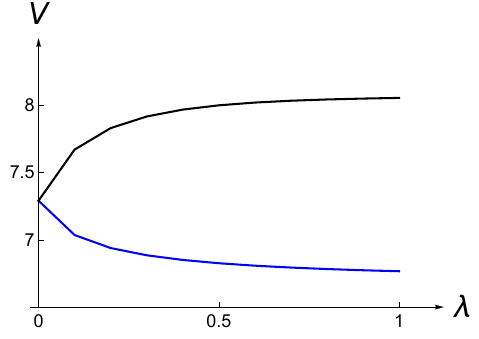
Figure 2. The value function V w.r.t. λ . The parameter set is r = δ = 0.03, σ = 0.3, X 0 = 10, K 1 = 10, K 2 = K 1 ( 1 + γ ) , γ = ± 0.2, λ ∈ ( 0,1 ) . We plot the value function for γ = − 0.2 (black upper line) and γ = 0.2 (blue lower line).